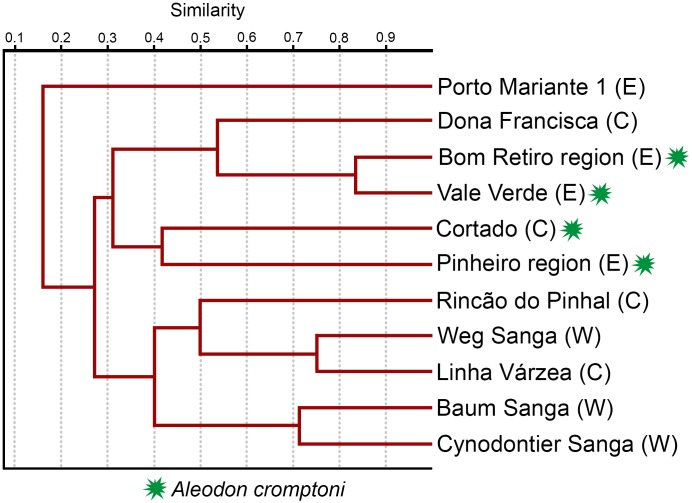
Dendrogram of main localities of the state of Rio Grande do Sul yielding fossil tetrapods of the Dinodontosaurus AZ (see data matrix in S1 File).Cophenetic correlation coefficient = 0.8474. (W), and (C), and (E) refers to the West, Central, and East portions, respectively, of the state of Rio Grande do Sul.